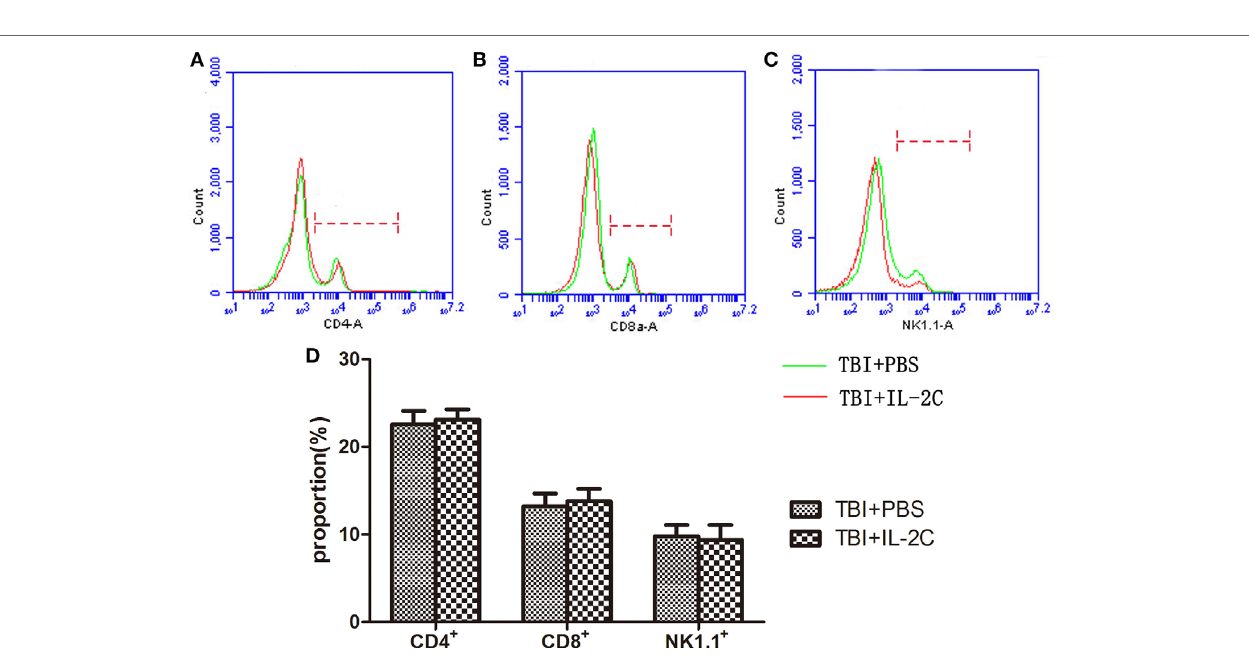
FigUre 4 | Flow cytometry was used to count the number of (a) CD4 + , (B) CD8 + , and (c) NK1.1 + cells isolated from the spleen on day 3 post-injury. We observed that treatment with IL-2C had no effect on the proportion of each lymphocyte subtype. (D) Bar graphs indicate that there was no difference between the PBS- and IL-2C-treated groups. Data are presented as the mean ± SD; * p < 0.05 and # p < 0.01 ( n = 5 mice/group).